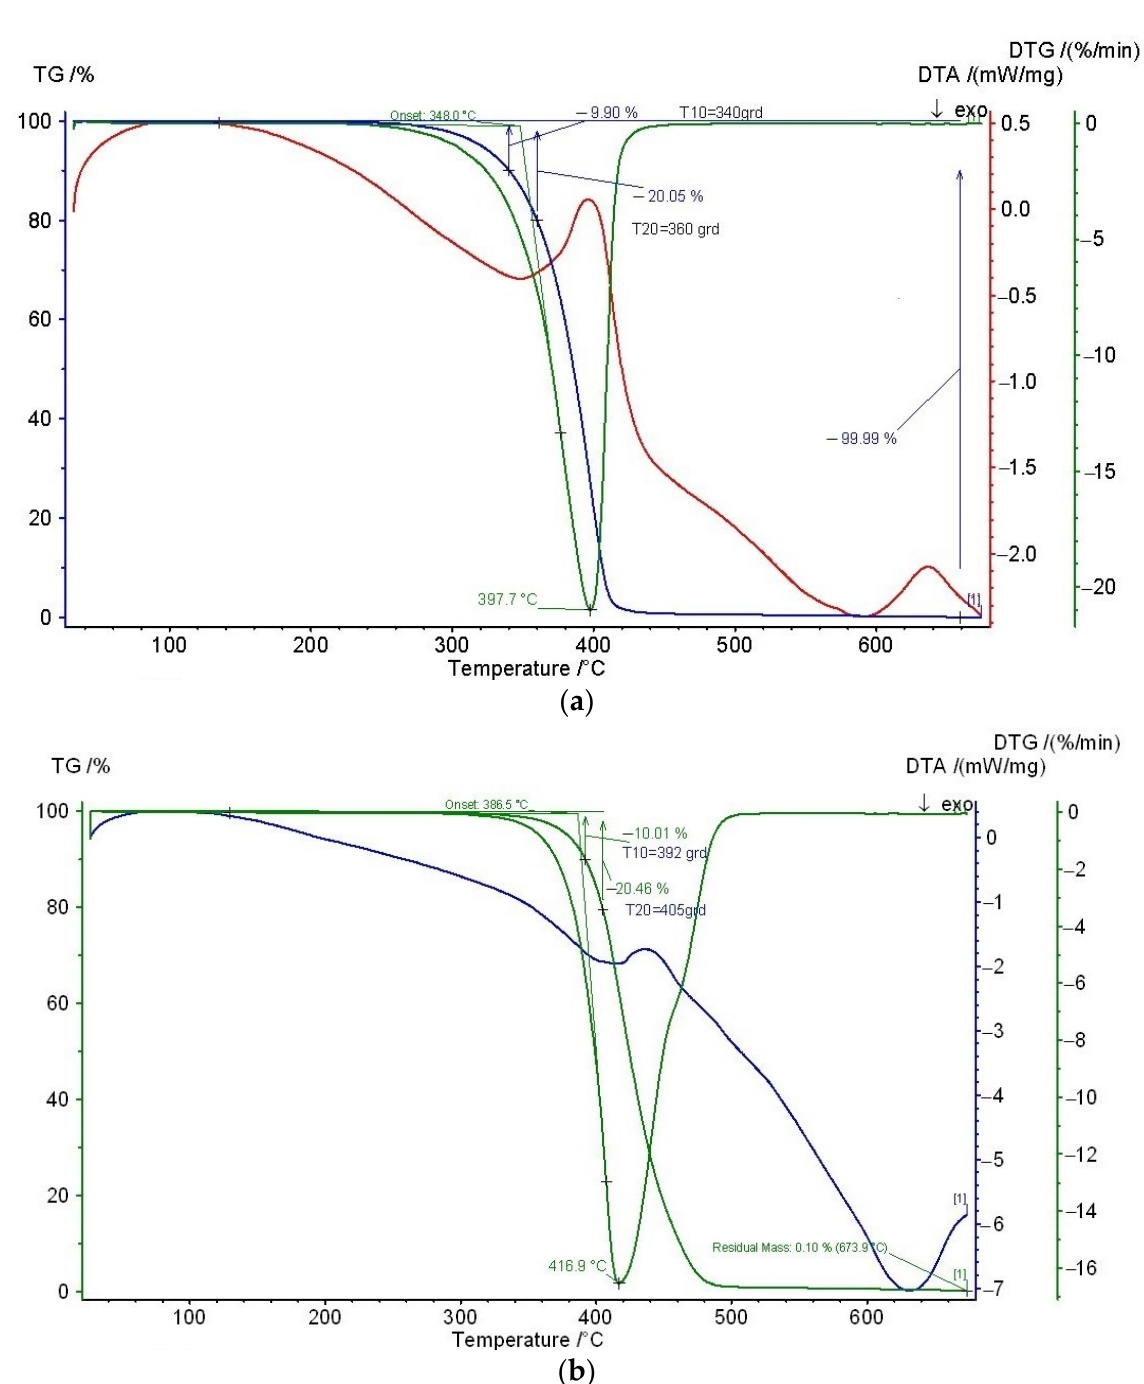
Figure 1. Thermal stability of ( a ) vitamin E, and ( b ) cold-pressed rosehip seed oil by means of thermogravimetric analysis.